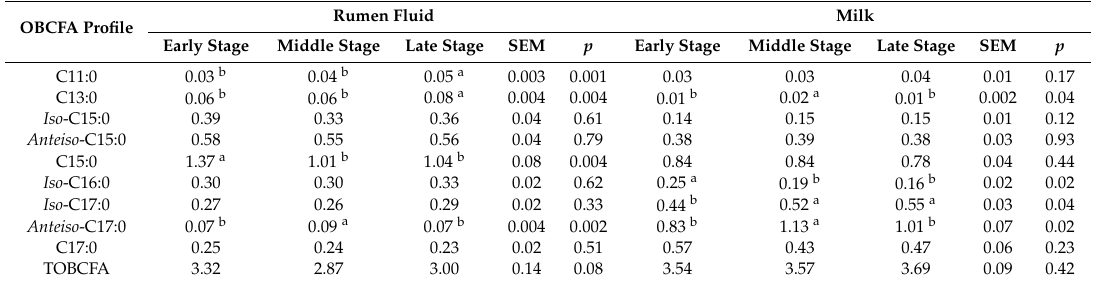
OBCFA, odd- and branched-chain fatty acids; TOBCFA, the total odd- and branched-chain fatty acids. a, b, c, means with di ff erent letters within the same line and the same item di ff er significantly ( p < 0.05). SEM = standard error of mean.